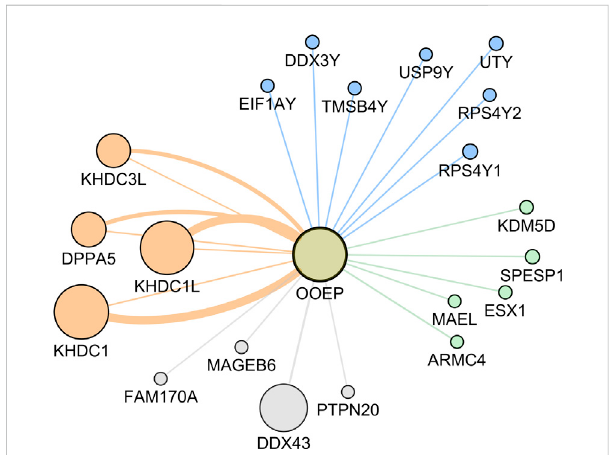
FIGURE 3 Oocyte expressed protein (OOEP) gene-gene co-expression network.Theedgesconnecting OOEP withothergenesrepresentco- expression, and larger circles mean stronger evidence of gene co- expression. Orange means genes related with human reproduction; gray: no associated with human reproduction; green: related with spermatogenesis and/or male infertility; blue: located in the Y chromosome. DPPA5 (Developmental Pluripotency Associated 5); KHDC1 (KH Domain Containing 1); KHDC1L (KH Domain Containing 1 Like); KHDC3L (KH Domain Containing 3 Like); FAM170A (Family With Sequence Similarity 170 Member A); DDX43 (DEAD-Box Helicase 43); MAGEB6 (MAGE Family Member B6); PTPN20 (Protein Tyrosine Phosphatase Non-Receptor Type 20); ARMC4 (Armadillo Repeat-Containing Protein 4); ESX1 (ESX Homeobox 1); KDM5D (Lysine Demethylase 5D); MAEL (Maelstrom Spermatogenic Transposon Silencer); SPESP1 (Sperm Equatorial Segment Protein 1); EIF1AY (Eukaryotic Translation Initiation Factor 1A Y-Linked); DDX3Y (DEAD-Box Helicase 3 Y-Linked); RPS4Y1 (Ribosomal Protein S4 Y-Linked 1); RPS4Y2 (Ribosomal Protein S4 Y-Linked 2); TMSB4Y (Thymosin Beta 4 Y-Linked); USP9Y (Ubiquitin Speci fi c Peptidase 9 Y-Linked); UTY (Ubiquitously Transcribed Tetratricopeptide Repeat Containing,